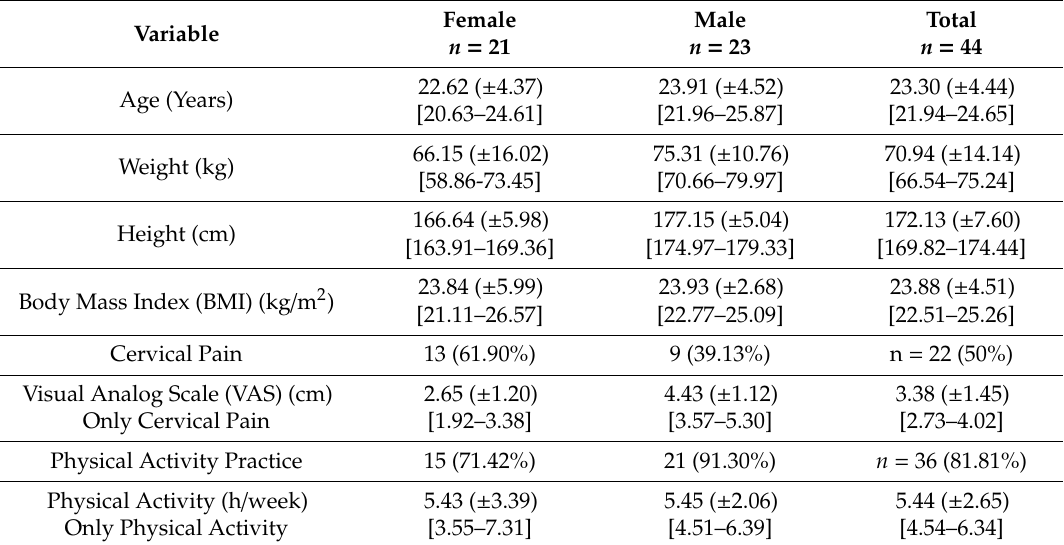
Table 1. Demographic characteristics and descriptive values.